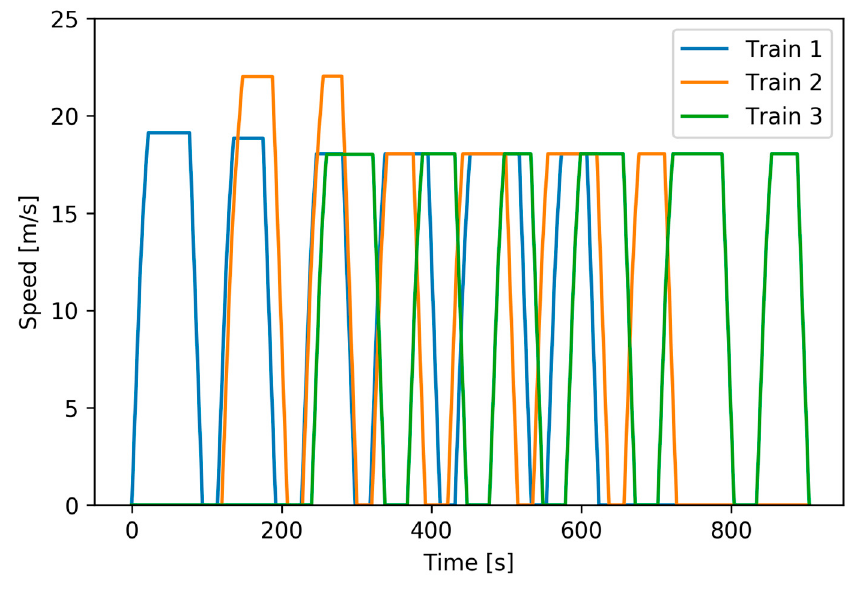
Figure 15. Speed of trains under a 13.60 s delay in the three-train network. Table 7. Energy consumption and average spending time during the testing process under continuously sampling random disturbances in the three-train